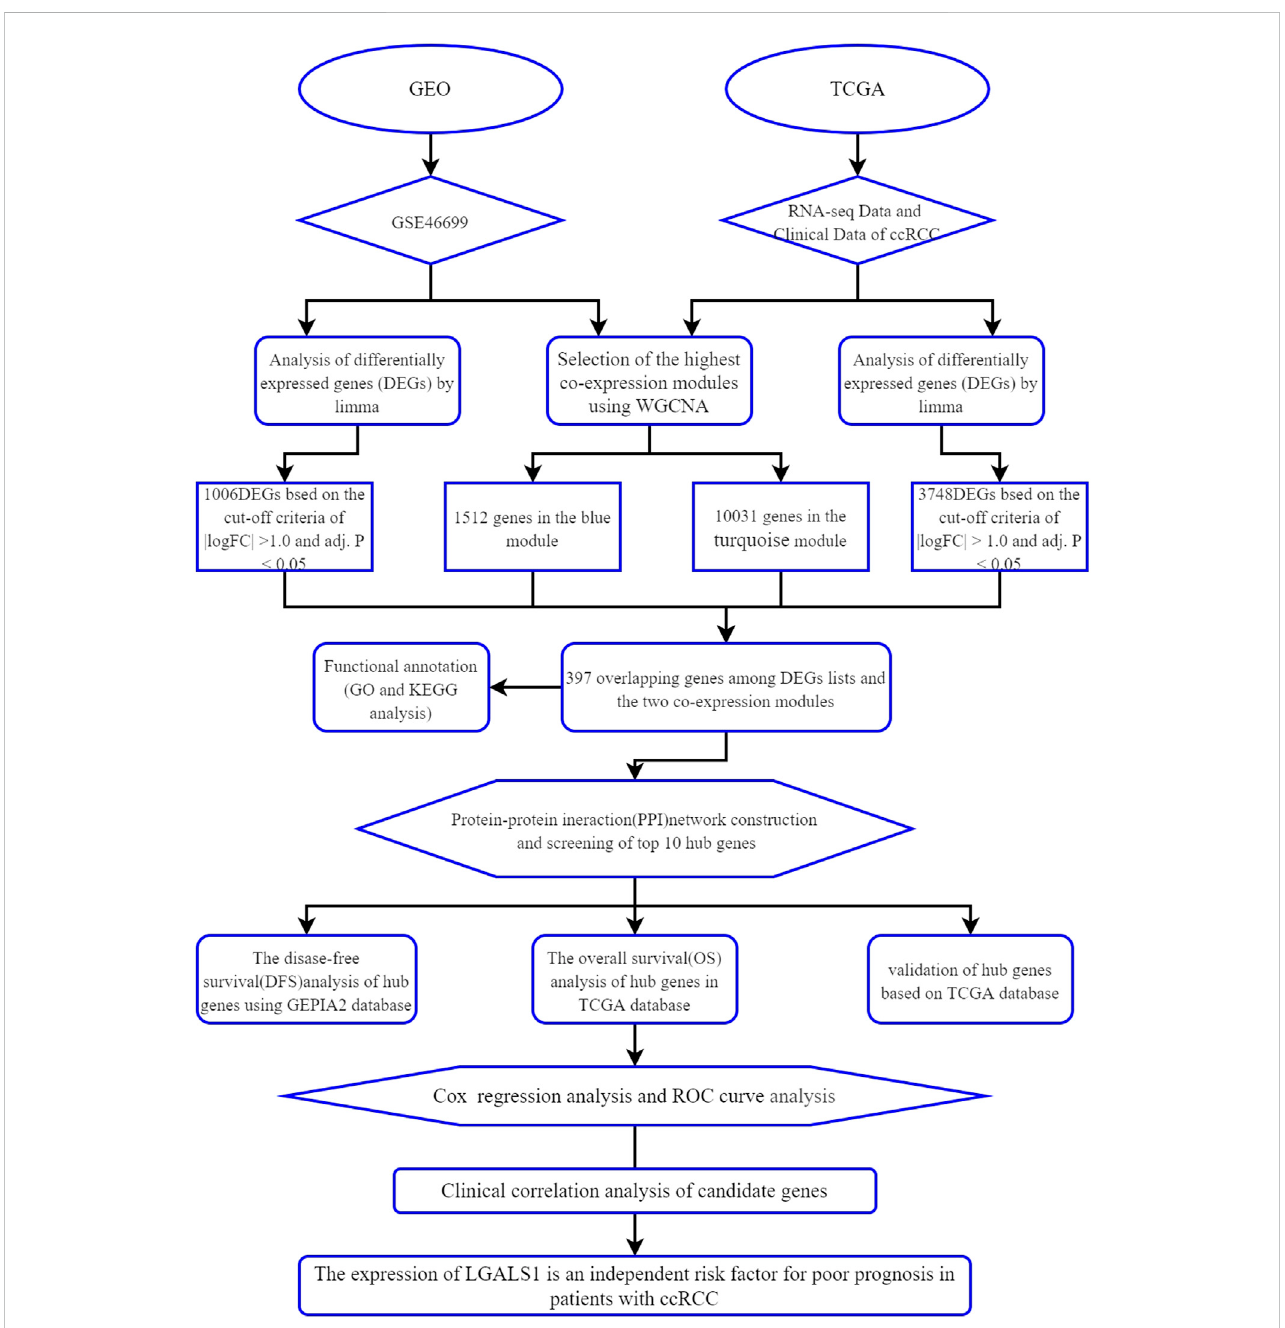
FIGURE 1 Work fl ow of this